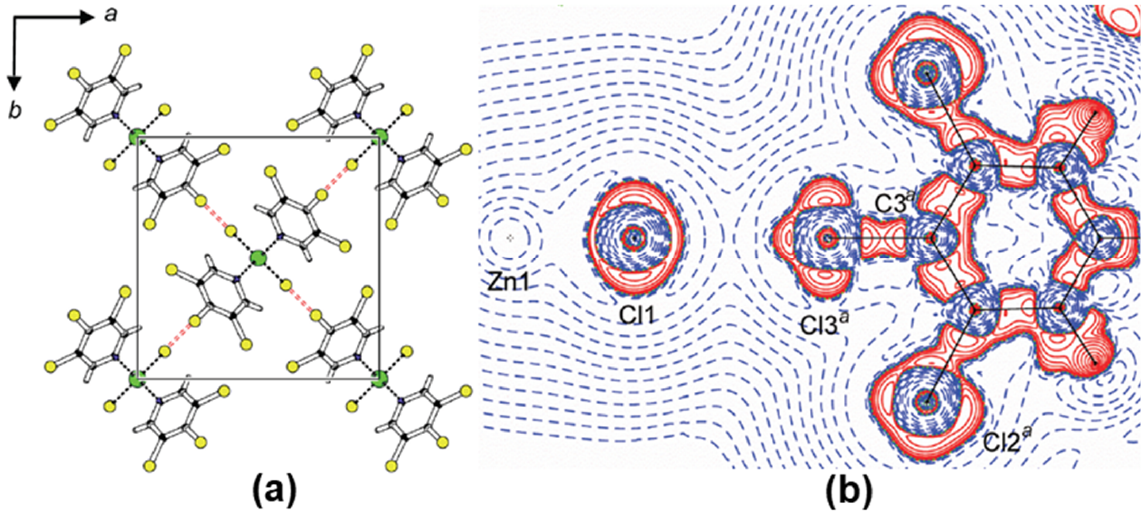
Figure 5. ( a ) The packing diagram and ( b ) the Laplacian map showing Cl∙∙∙Cl interactions in ZnCl 2 (3,4,5-trichloropyridine) 2 . Adopted from the reference [41] .